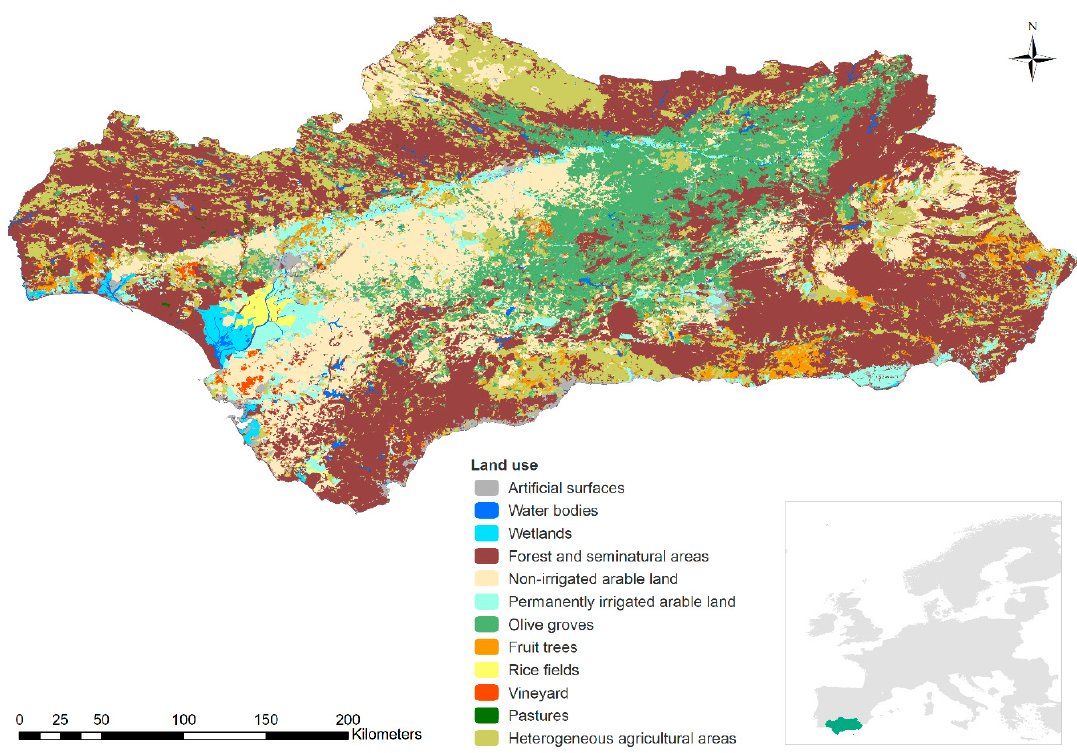
Figure 1. Location and types of land use in Andalusia.